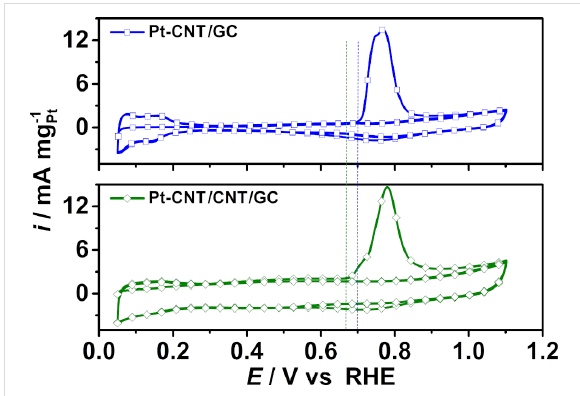
Figure 9: CO ad stripping voltammograms of Pt-CNT/GC and Pt-CNT/ CNT/GC monitored at 20 mV s − 1 in CO-purged and subsequently N 2 -purged 0.1 M HClO 4 solution. The vertical dashed lines are intended as a guide for the eye.